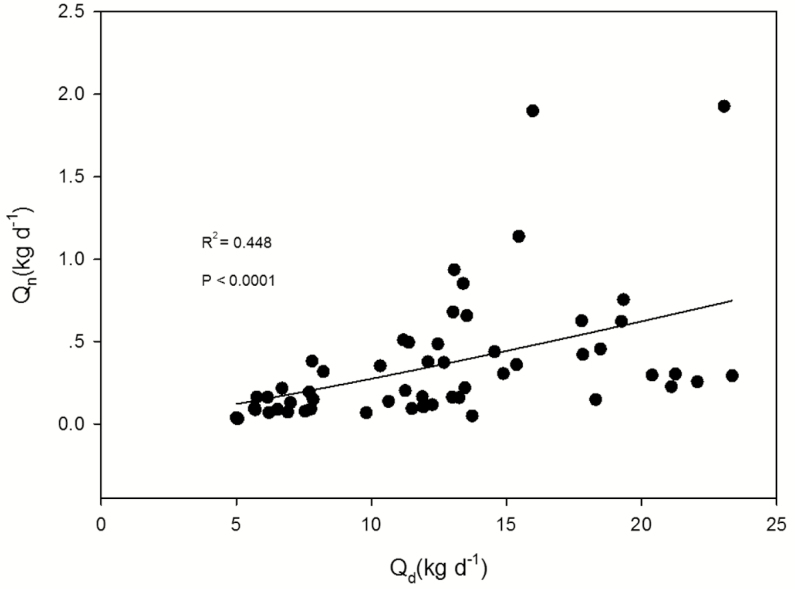
Regression analysis of the night-time water use (Qn) and the daily water use (Qd): y = 0.0078x1.4110 (R2 = 0.448, P < 0.0001).